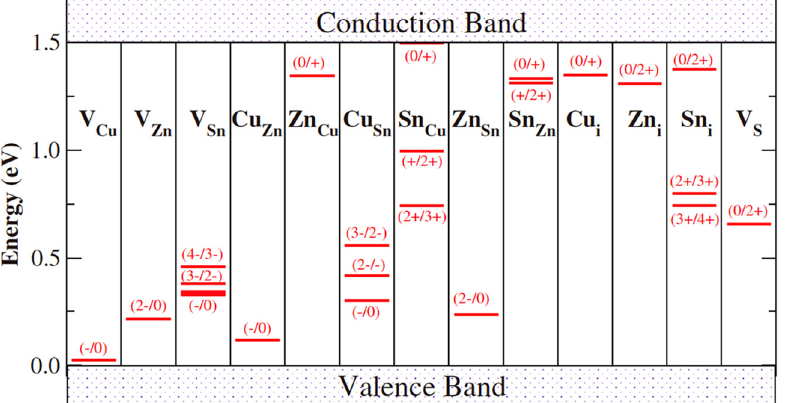
Figure 5: Transition - energy levels of point defects in the E g of CZTS. Reprinted with permission from ref. [ 59 ] . ©2010 American Physical